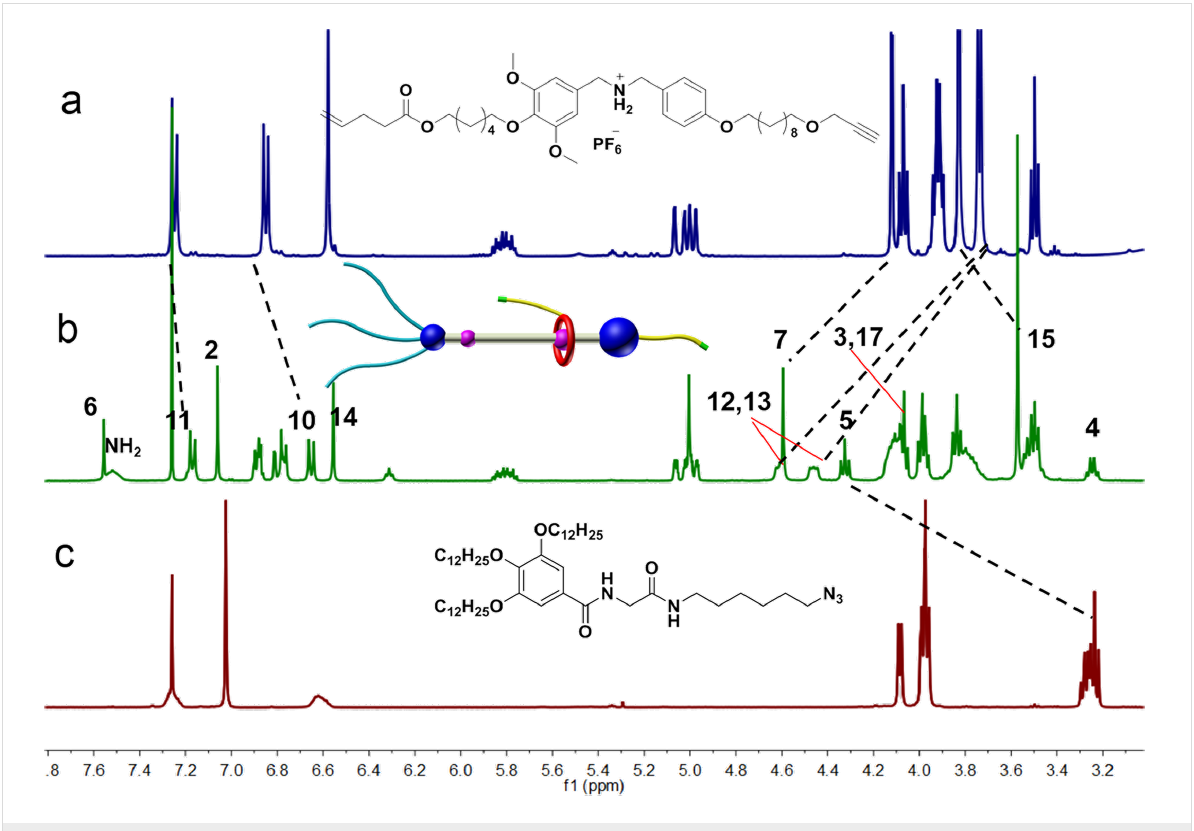
Figure 1: Partial 1 H NMR spectra (400 MHz, CDCl 3 , 298 K). (a) Compound 5 , (b) target [2]rotaxane R1 , (c) azide compound 8 .